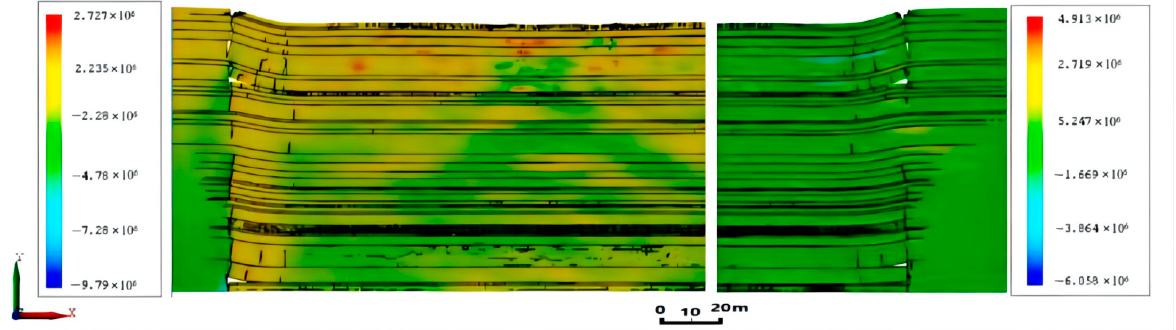
Figure 6. Cloud map bedrock stress distribution ( left is vertical, right is horizontal).